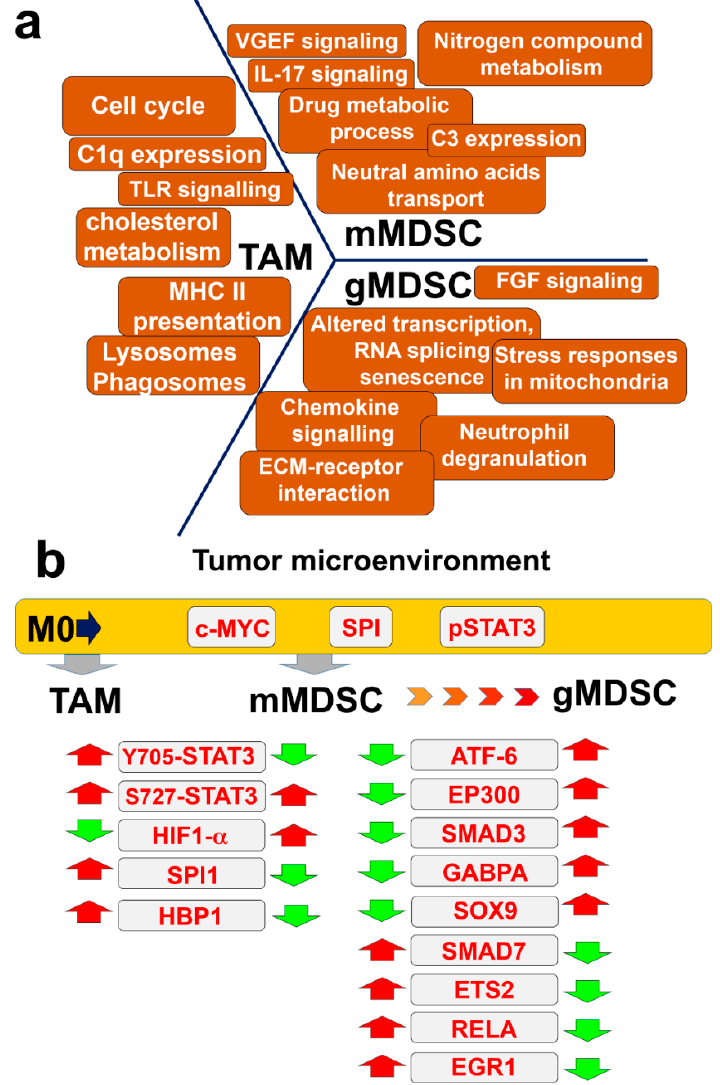
Figure 8. Proteome atlas of tumor-polarized myeloid cell subsets. ( a ) Processes associated to each specific myeloid subset, as indicated. ( b ) Hierarchy of transcription factors associated to each myeloid cell subset. Red arrows, up-regulated; green arrows, down-modulated.